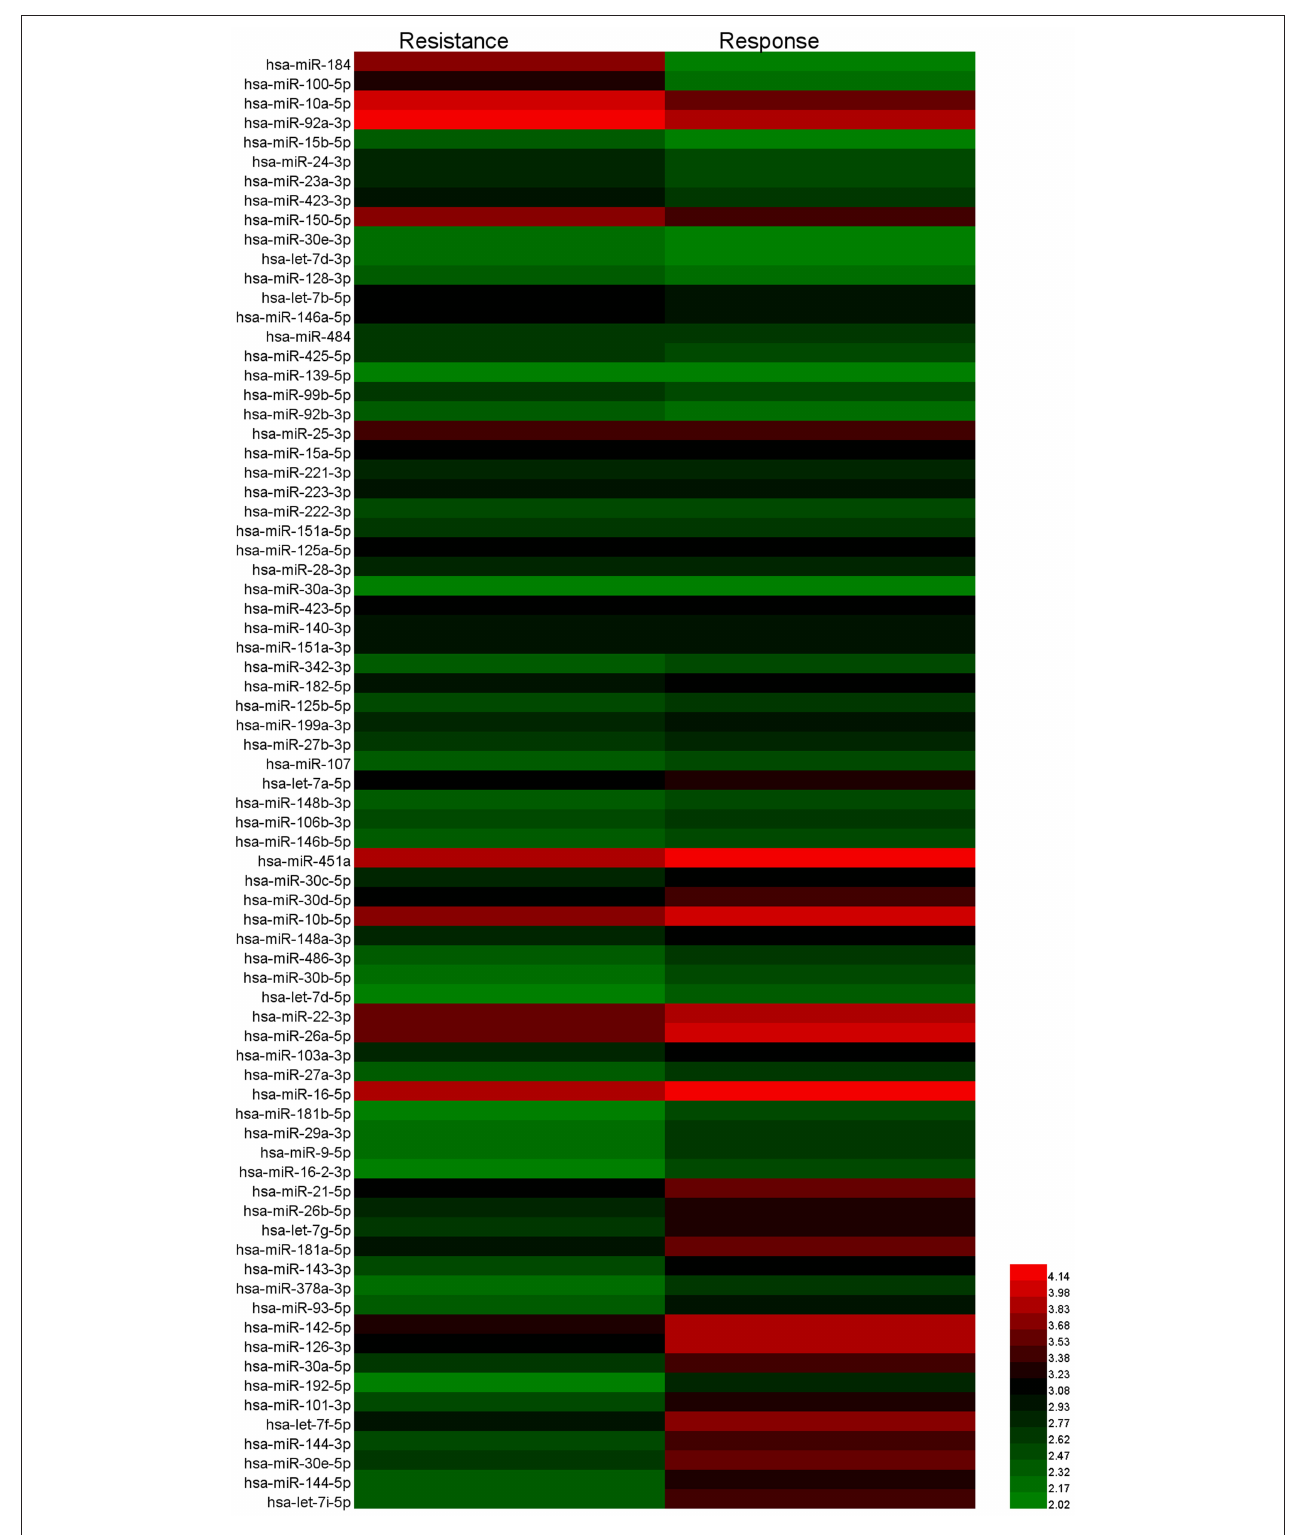
FIGURE 3 | Heat map showing the significantly upregulated and downregulated miRNAs in the resistance group compared to the response group.